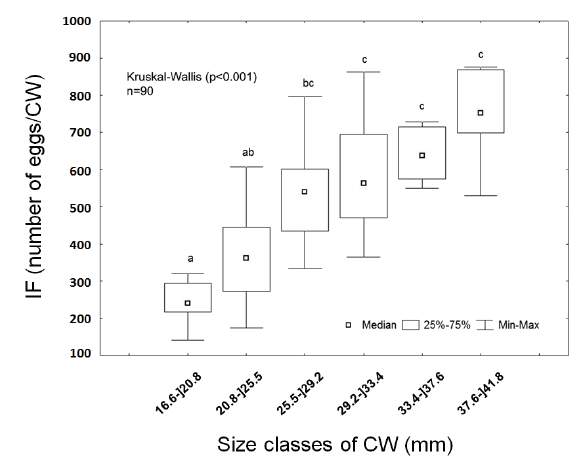
Figure 2. Eriphia gonagra (Fabricius, 1781). Fecundity index (FI) values (median, standard deviation, and maximum and minimum) for each size class. Median with same letter did not differ statistically (Kruskal-Wallis test; α =